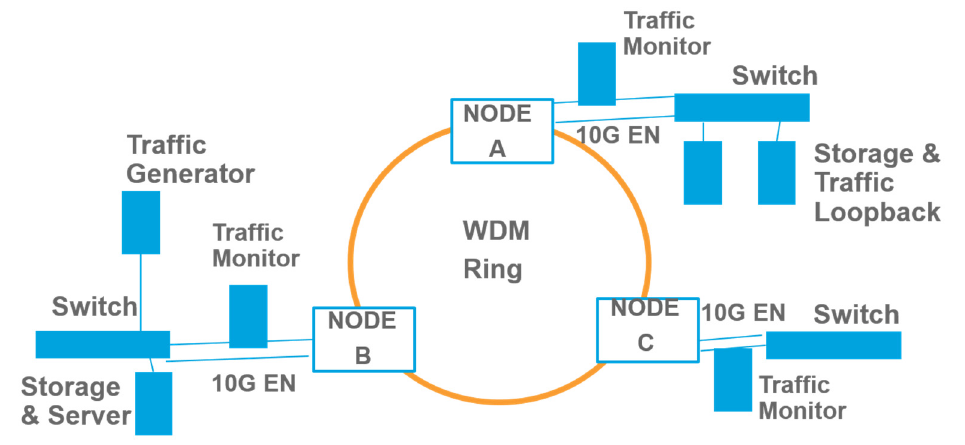
Figure 3. Packet over optical wavelength division multiplexing (WDM) test bed using SDN and network hypervisor